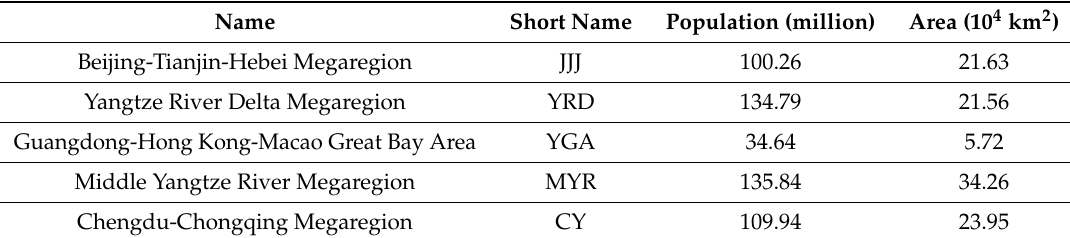
Table 1. Information of megaregions.